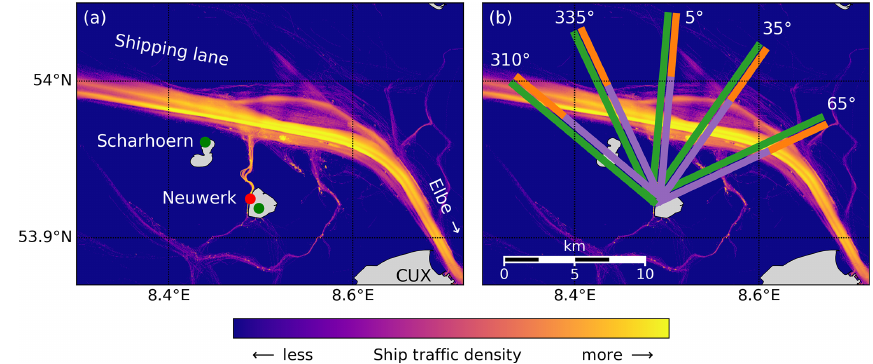
Figure 1. (a) Ship traffic density map calculated from all received AIS messages (2013–2016) showing the main shipping lane from the North Sea into the Elbe river close to the measurement site on a radar tower on the island Neuwerk (red dot). Wind measurements are available on Neuwerk as well as the neighboring island Scharhörn (green dots). (b) Effective horizontal light paths in UV (purple line) and visible spectral ranges (green line) for the five azimuthal viewing directions of the MAX-DOAS instrument (310, 335, 5, 35, 65 ◦ , with respect to north), shown for typical light path lengths of 9km (UV) and 13km (vis), respectively. The difference between both paths, (cid:49)L , is highlighted by the orange